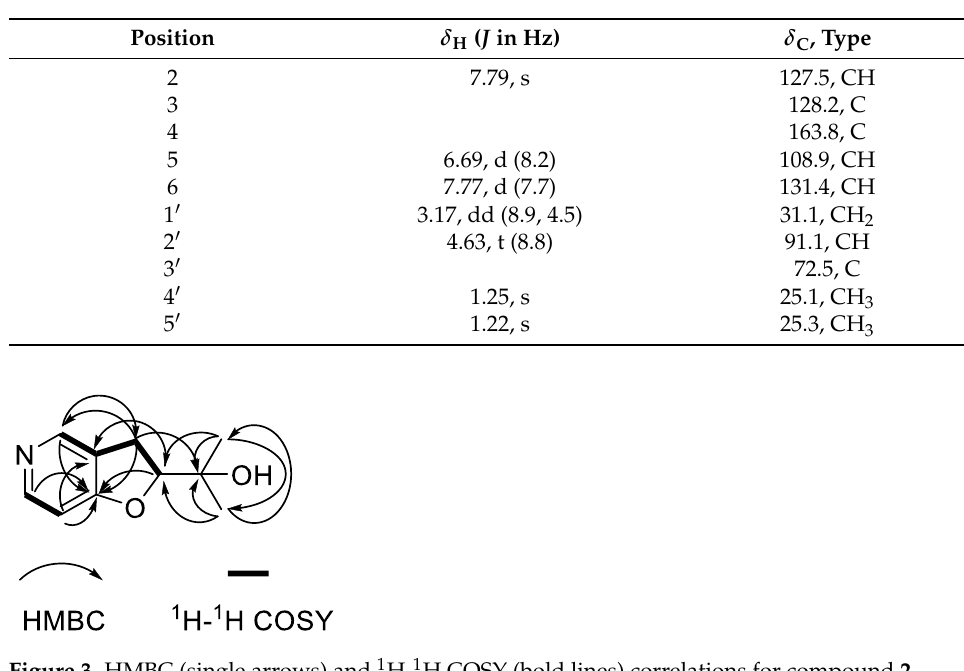
Table 2. 1 H (800 MHz) and 13 C (200 MHz) NMR data for compound 2 (methanol- d 4 ).